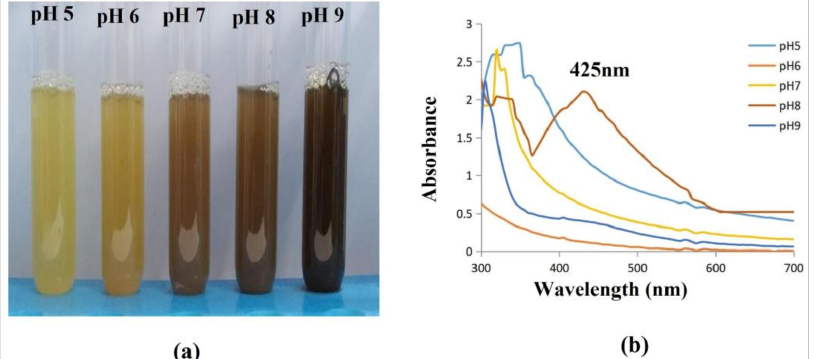
Figure 10. Effect of pH on synthesised AgNPs. ( a ) The AgNP synthesis was observed as a color shift towards brown indicating that the particle size gradually increases with concentration ( b ). At pH 8, stable AgNPs were formed, which was confirmed with a spectral peak at 425 nm; the solutions with a pH of 5, 6, 7, 9 showed unstable